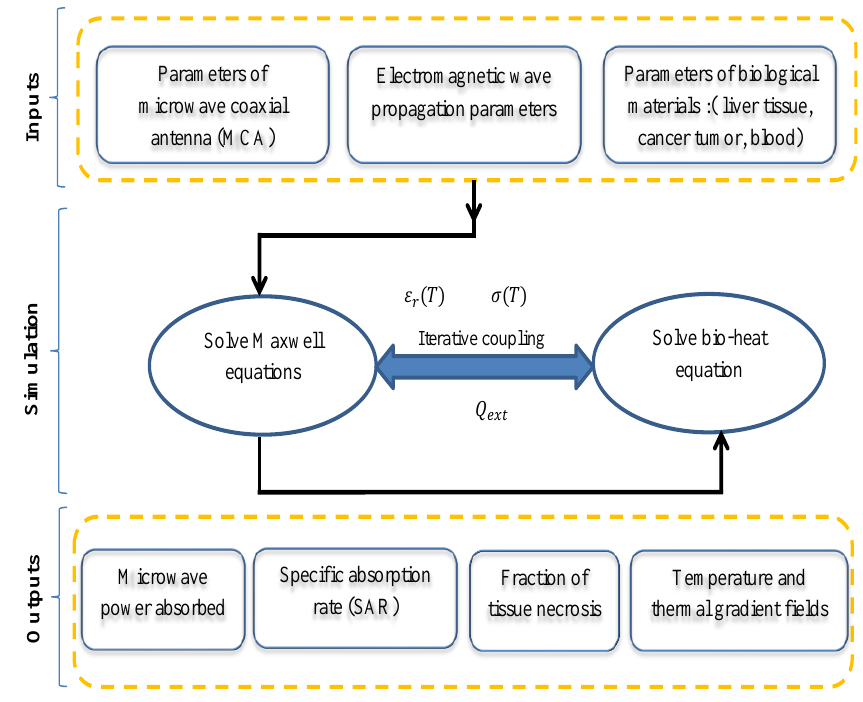
Figure 5. Flow chart describing the simulation scheme.